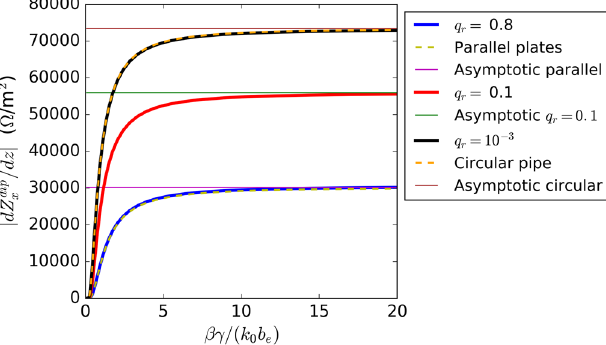
FIG. 4. Dependence of space charge horizontal impedance with wave number for b e ¼ 3 . 5 cm and β ¼ 0 . 5 . Comparison of Eq. (34) (black, blue and red curves) with the circular pipe case given by Eq. (35) (dashed orange curve), with IW 2 D code results for parallel plates (dashed yellow curve), and with the asymptotic expressions (36) and (38) valid for low frequency (brown, magenta and green